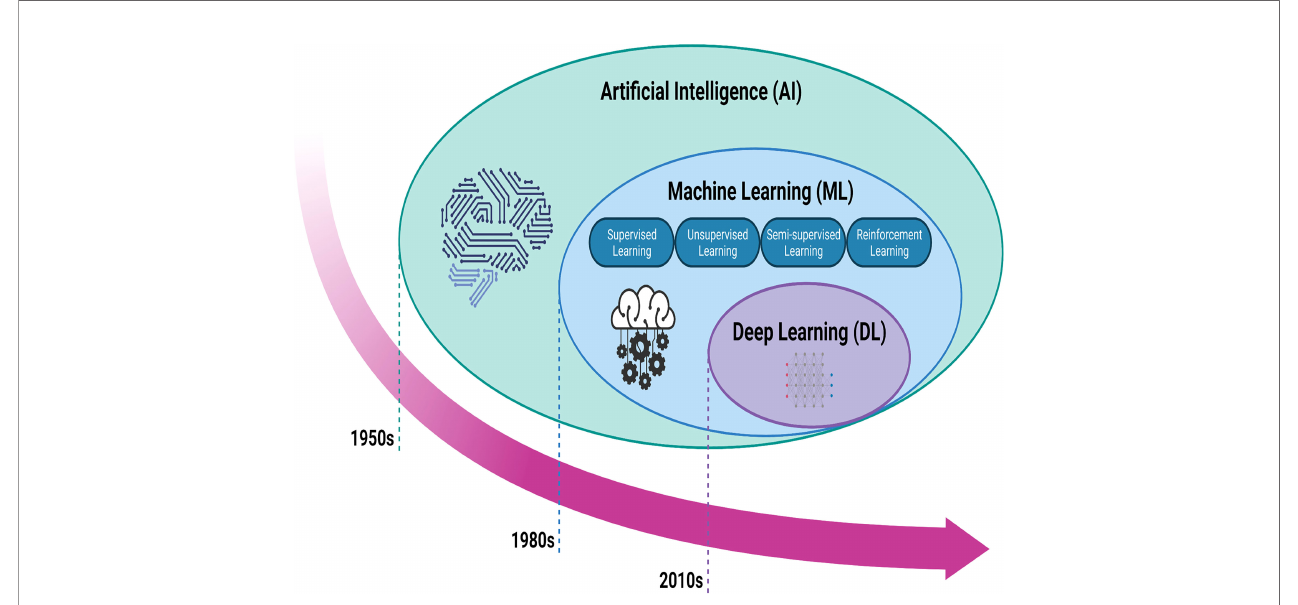
FIGURE 1 | Arti fi cial intelligence methods and timeline. Machine learning is a form of arti fi cial intelligence that could be classi fi ed as supervised learning, unsupervisd learning, semisupervised learning, and reinforcement learning. Deep learning is a form of machine learning. AI: arti fi cial intelligence; ML: machine learning; DL: deep